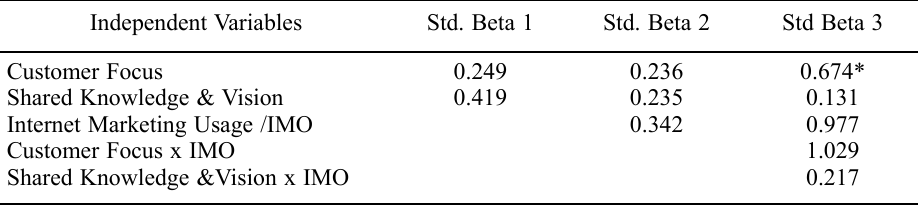
Table 2. Regression analysis – the moderating effect of Internet marketing orientation on the relationship between customer focus, shared knowledge & vision and innovation capabilities Independent Variables